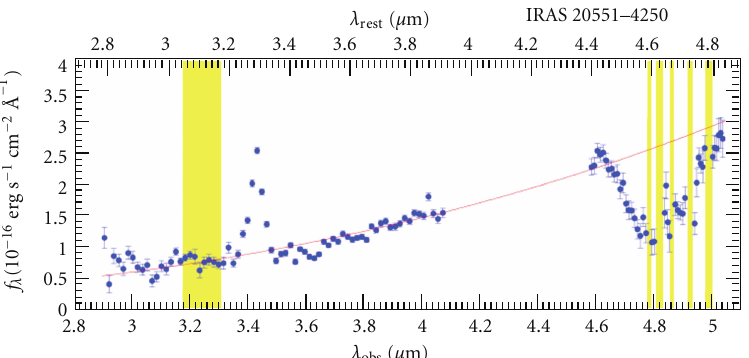
Figure 2: L + M band of IRAS 20551-4250 [17]. The heavily reddened continuum (red curve) is present together with strong CO absorption in the M -band. The regions of bad atmospheric transmission are shaded in yellow. (Note the units on the vertical axis, f λ ∝ λ − 2 f ν .)